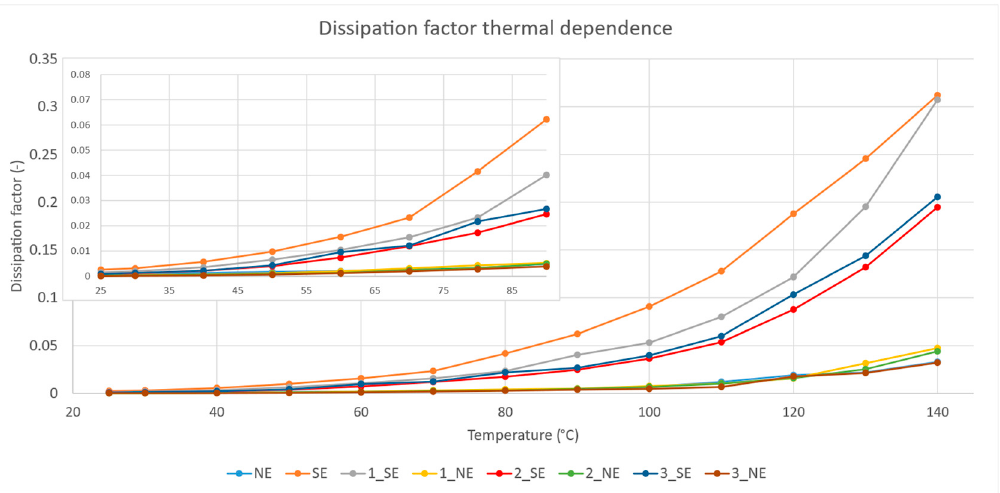
Figure 5. Dissipation factor thermal dependence (from 25 °C to 140 °C) of all examined fluids. The samples showed a monotonically increasing dissipation factor with temperature. Detailed curves at lower temperatures are shown in the upper left corner.